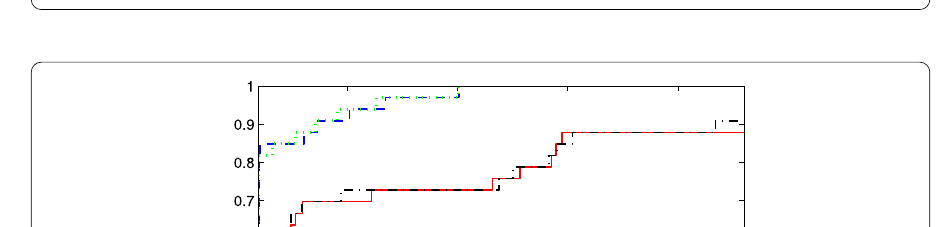
Figure 1 Performance profiles of these methods (NI).